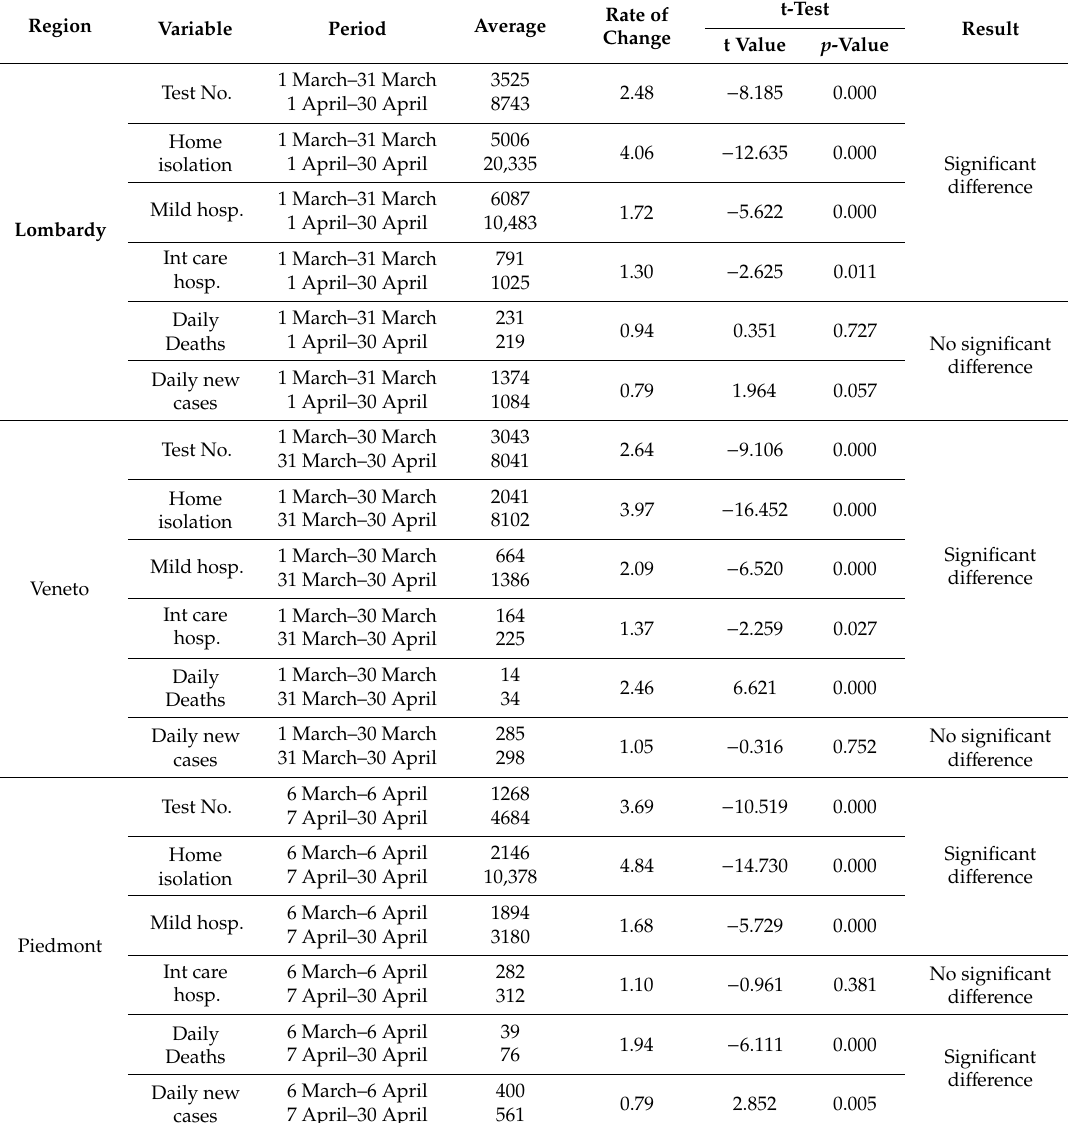
Table 4. T-test results within two periods (Lombardy, Veneto, and